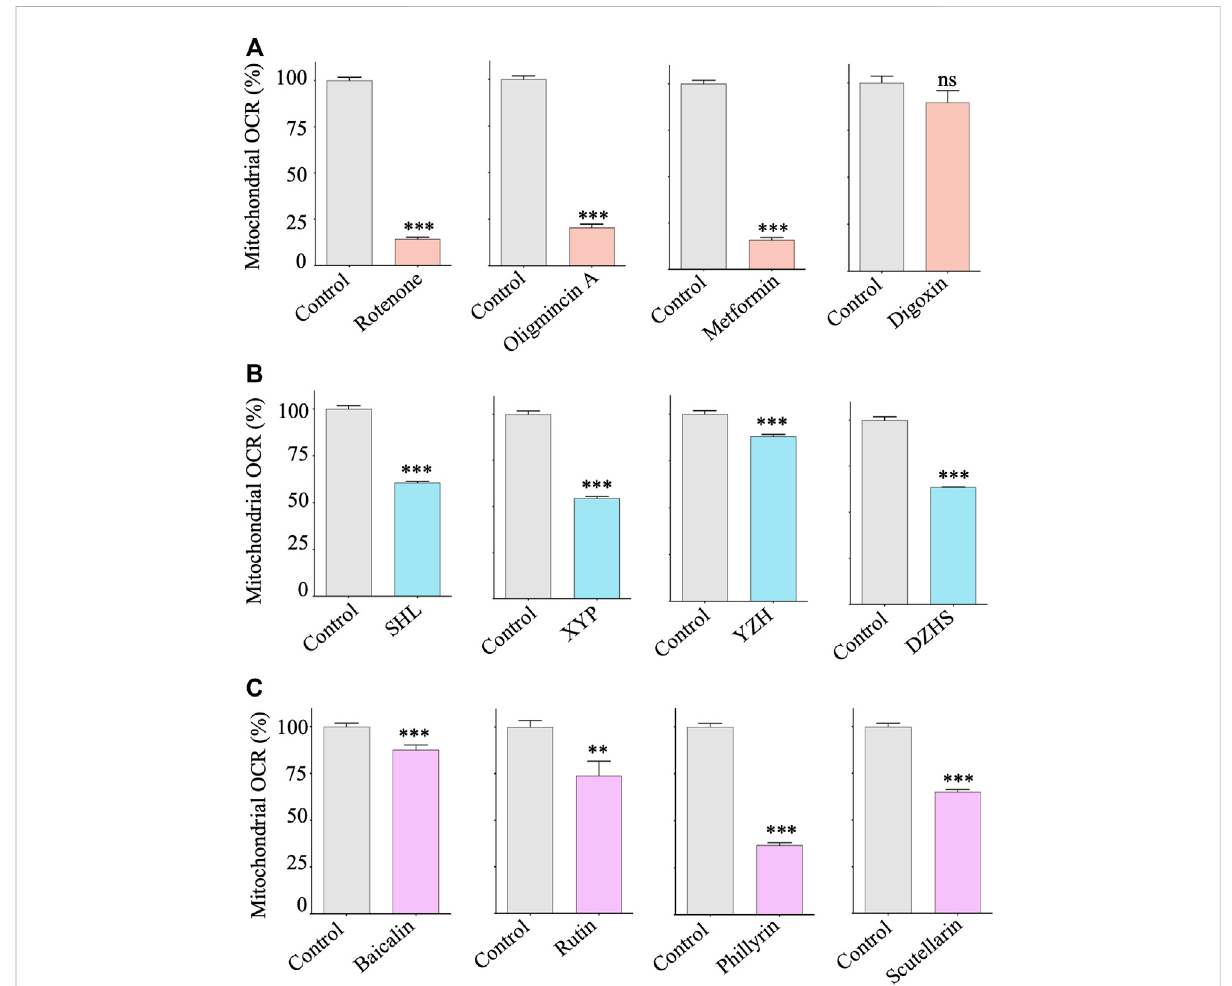
FIGURE 5 Effects of mitochondrial toxic TCM injections and ingredients on the respiration of HepG2 cells. HepG2 cells were treated with control compounds, TCM injections and ingredients with indicated concentrations for 24 h. The mitochondrial respiration rate (OCR) was assessed by the InstechFiberOptic Oxygen MonitorSystem. (A) Controlcompounds:rotenone(2 μ M),oligomycinA(2 μ M),metformin(10 mM),anddigoxin (2 μ M). (B) TCM injections: SHL (200 μ g/ml), XYP (500 μ g/ml), YZH (0.01 ml/ml), and DZHS (200 μ g/ml). (C) TCM ingredients: baicalin (200 μ M),